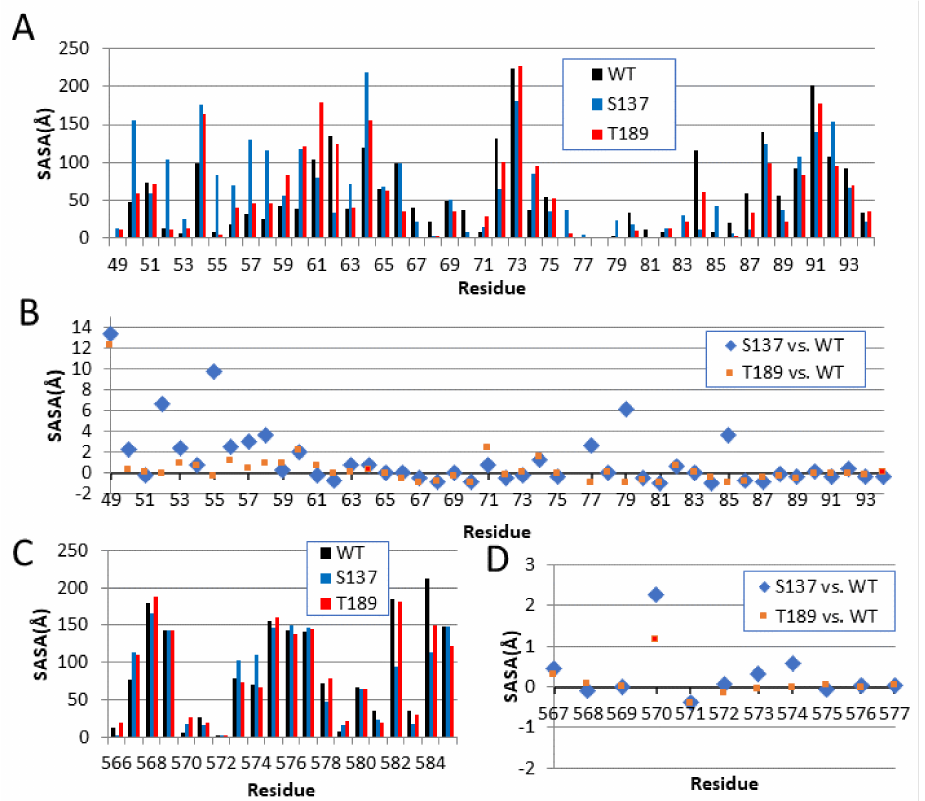
Figure 6. The solvent accessible surface area (SASA) of the three “100 ns” MD simulated structures (unphosphorylated WT at time 100 ns, S137, and T189 at time 100 ns). Phosphorylation of S137 increases the solvent accessibility at many of the residues. ( A ) SASA scores for residues 49–95 of WT (Black), S137 (Blue), and T189 (Red) at 100 ns simulation time, ( B ) The difference in SASA score for residues 49–95 (S137 vs. WT in Blue) and (T189 vs. WT in Red) normalized with respect to WT value. ( C ) SASA scores for residues 566–585 at 100 ns simulation time, WT (Black), S137 (blue), and T189 (Red). ( D ) The normalized difference in SASA score for residues 566–585 (S137 vs. WT in Blue) and (T189 vs. WT in